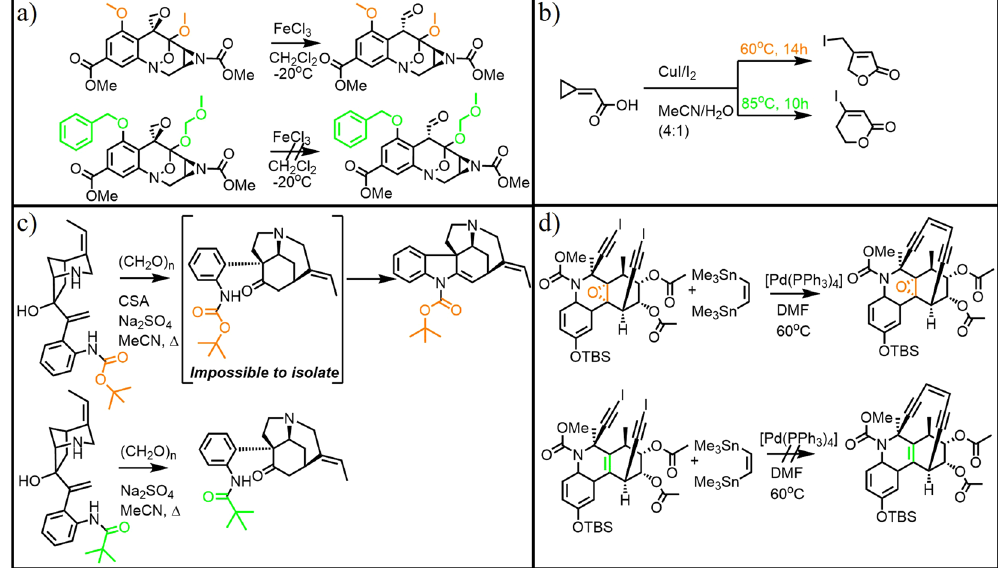
Figure 6. A challenge for Machine Learning: Minor structural changes in starting materials can dramatically influence the reaction outcomes. ( a ) Replacement of two O-protecting groups (orange OMe to green OBn and OMOM) in the intermediate in Danishefsky’s synthesis of ( + / − )-FR-900482 changes the lability of ether groups and prohibits rearrangement of an epoxide to an aldehyde 37 . ( b ) Minute changes in temperature alter reaction mechanism and result in different products 38 . ( c ) Small changes in electron density modify reactivity of N-pivaloyl and N-Boc protected anilines. The upper substrate reacts into an intermediate that is impossible to isolate and thus leads to a product that is markedly different than the one obtained from the lower substrate differing in only one atom (oxygen) 39 . ( d ) Presence of the epoxide ring in the tricyclic moiety allows for close proximity of the terminal iodides enabling double Pd-mediated coupling. In contrast, when the epoxide is replaced by a double bond, the iodides are further apart and no cyclization is observed 40